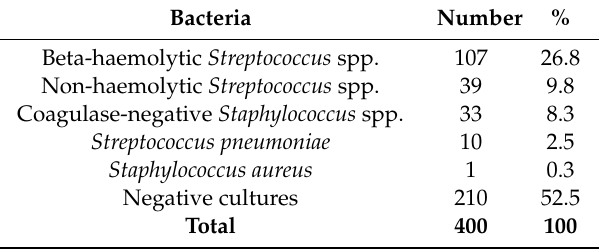
Table 2. Frequency of bacteria identified in oropharyngeal swabs obtained from healthy children aged 3–14 years in Bouak é , central C ô te d’Ivoire in March 2017.